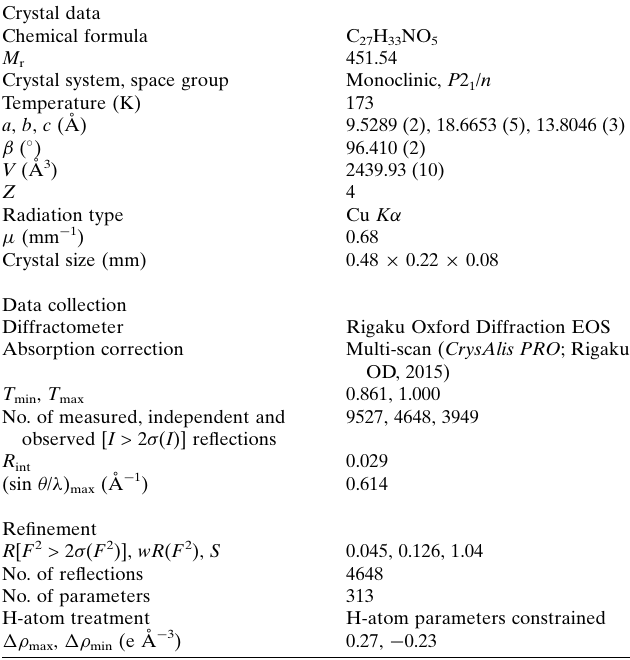
Table 3 Experimental details. Crystal data Chemical